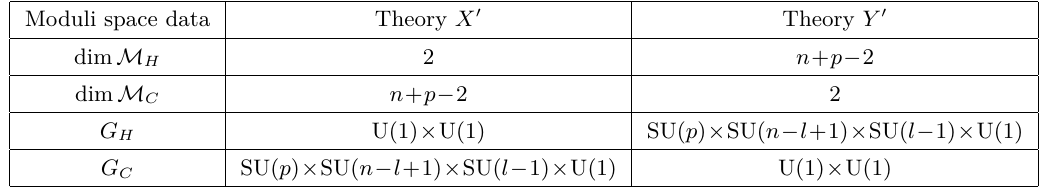
Table 5 . Summary table for the moduli space dimensions and global symmetries for the mirror pair in figure